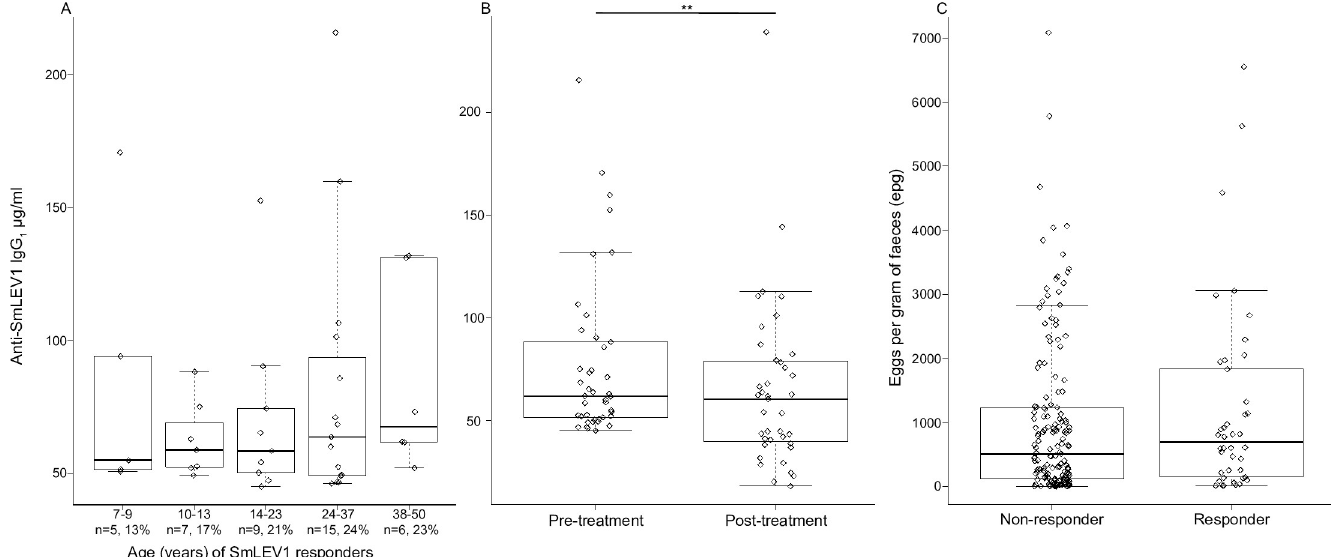
Fig 5. Anti-SmLEV1 IgG 1 responses drop after PZQ treatment in an endemic human cohort. Descriptions of cohort selection, quantitative parasitology, and treatment regimens for this study can be found in a previous publication [25]. (A) The level of anti-SmLEV1.3 IgG 1 in responders does not significantly change across the different age groups. The number and percentage of responders are shown for each age group. (B) The level of anti-SmLEV1.3 IgG 1 drops after treatment with praziquantel (p < 0.005, �� ). (C) The egg burden of SmLEV1.3 responders and non-responders does not significantly differ. The boxplots show the median (line) with the upper and lower quartile (box) as well as the upper and lower observation within 1.5x interquartile range (IQR) (whiskers). Individual data points are also